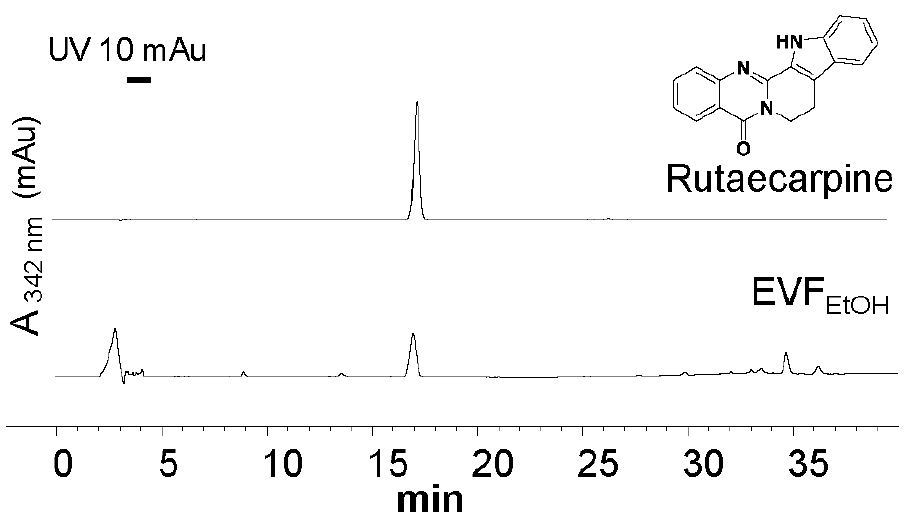
Figure 1. HPLC analysis of the ethanol extract of Evodiae Fructus (EVF EtOH ). The characteristic peak of pure rutaecarpine (0.5 mg/mL; upper trace) was found in the EVF EtOH extract (0.1 mg/mL; lower trace) at 10 µL. Absorbance was measured at 342 nm.